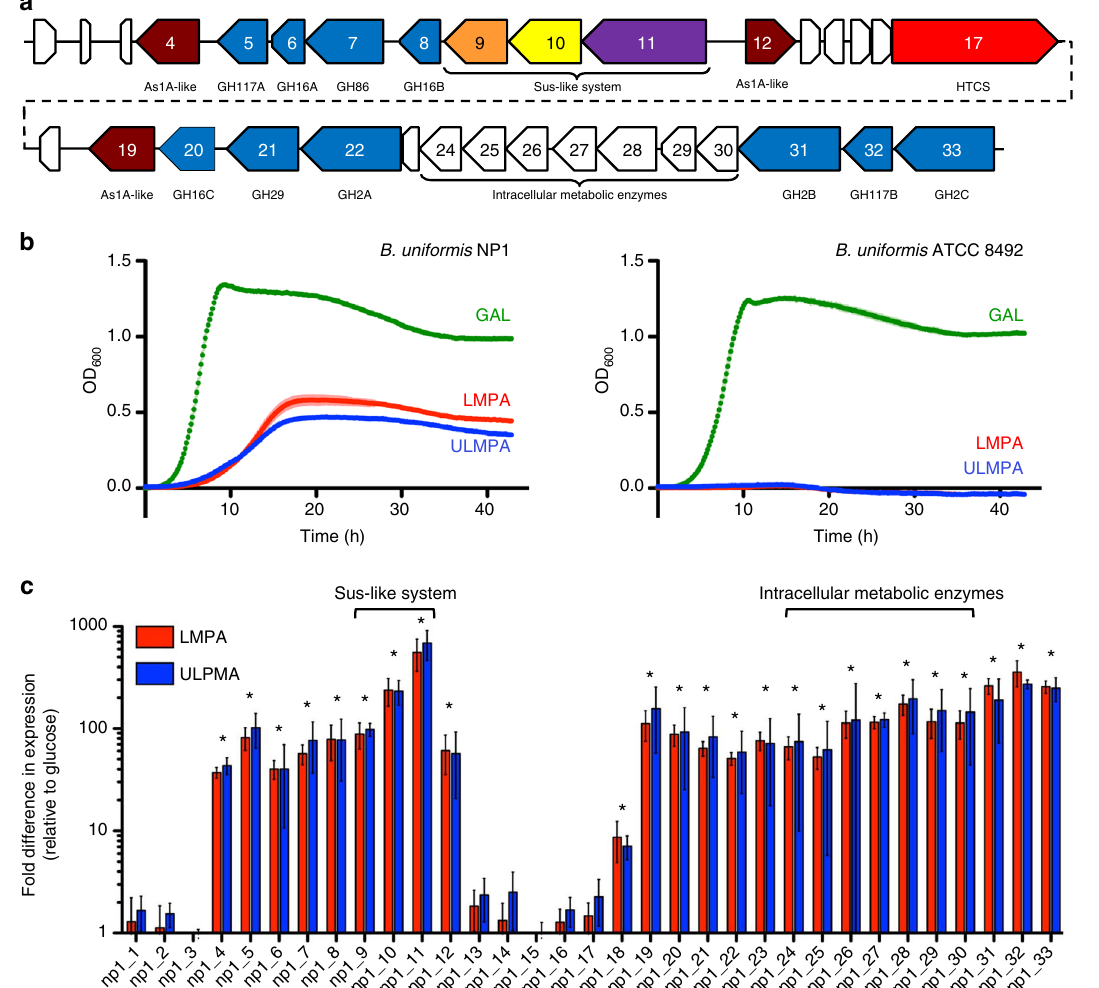
Fig. 1 Functional agarolysis is Bu NP1. a Schematic representation of the Ag-PUL drawn to relative size and with orientations illustrated with arrows. Genes are labeled from 1 to 33 ( np1 _1 – 33) and according to their predicted functions. Brown = sulfatases, blue = GHs, orange = SusE-like, yellow = SusD-like, purple = SusC-like, red = response regulator, and white = hypothetical proteins. Genes are labeled according to their CAZy classi fi cation. b Growth curves of agarolytic Bu NP1 (left panel) and non-agarolytic Bu ATCC 8492 (right panel) on GAL, LMPA, and ULMPA. The experiment was replicated three times, with four to eight observations per replicate; error (s.d.) is represented by trace thickness. c RT-PCR of the genes in the Ag-PUL. Relative expression (normalized to glucose) compared to HK genes is shown; statistical signi fi cance is represented as * p < 0.05. Vertical lines associated with histogram error bars (s.e.m.) represent three biological replicates, with six independent measurements